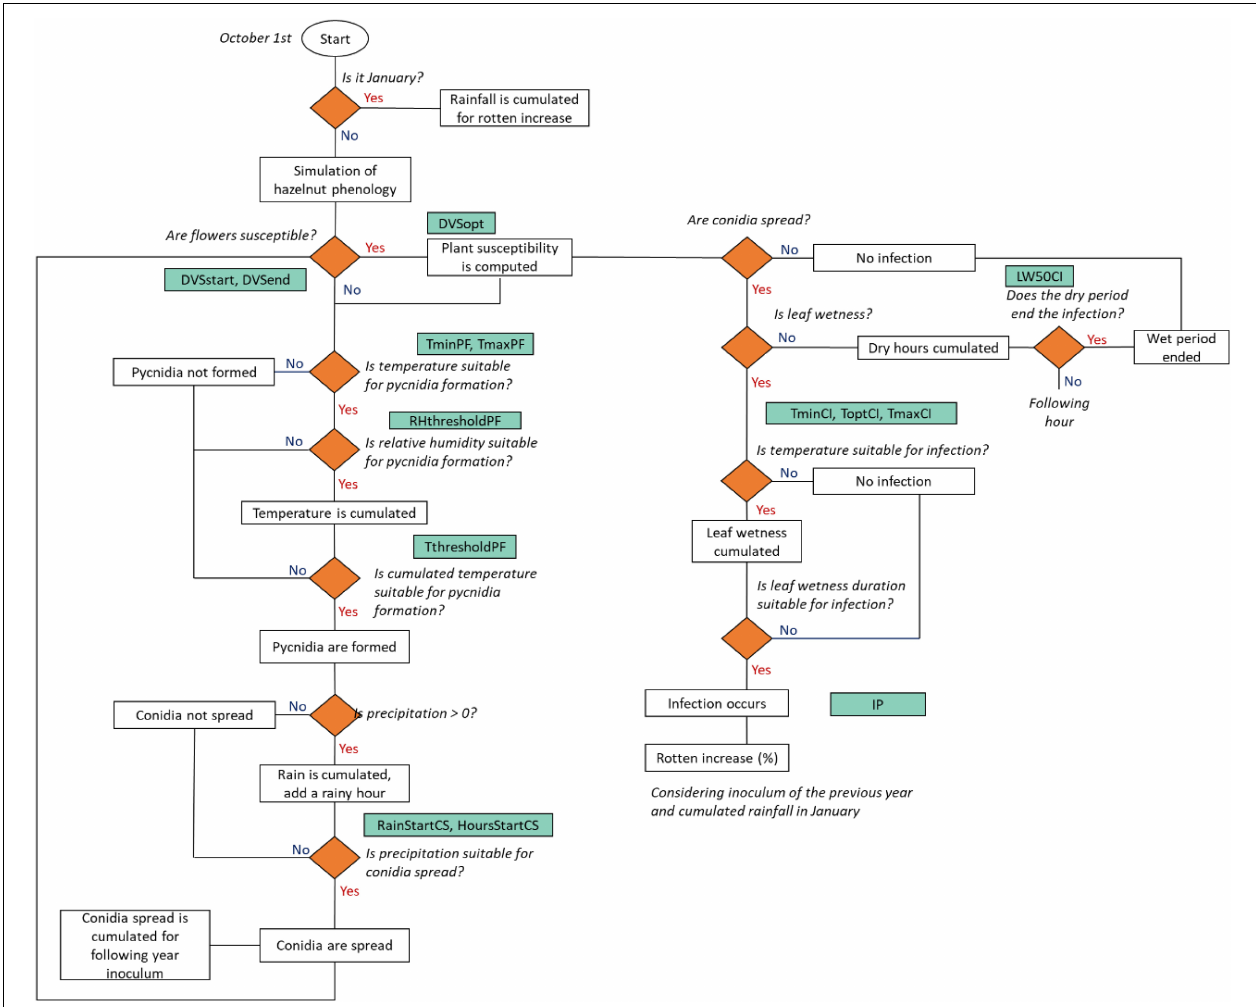
FIGURE 3 | A flowchart of the rotten incidence simulation model. Decisions are indicated as rhombi, parameters are reported in green boxes and model outputs/events are indicated as white boxes. The acronym, description, and units of the parameters are reported in Table 2